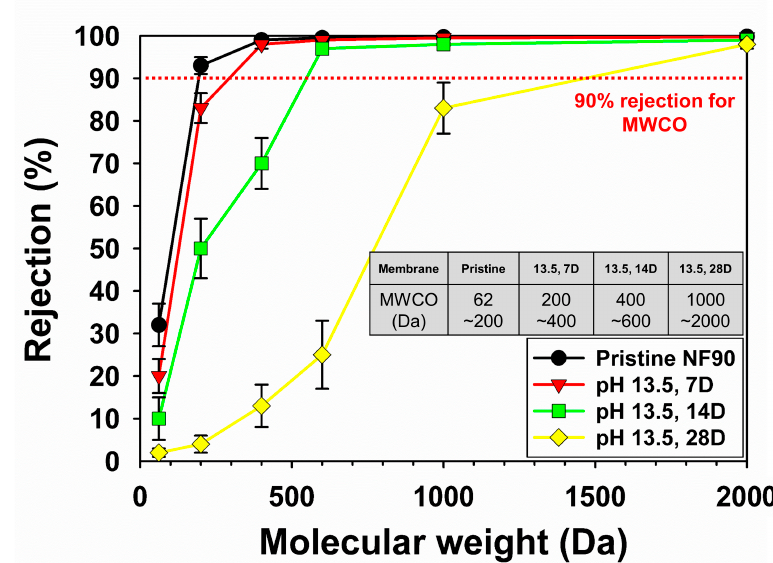
Figure 5. Effect of alkali hydrolysis on the molecular weight cutoff (MWCO) of NF 90 pristine and post-treated membranes (experimental conditions: 1000 mg L − 1 polyethylene glycol (PEG) solutions and 10 bar).